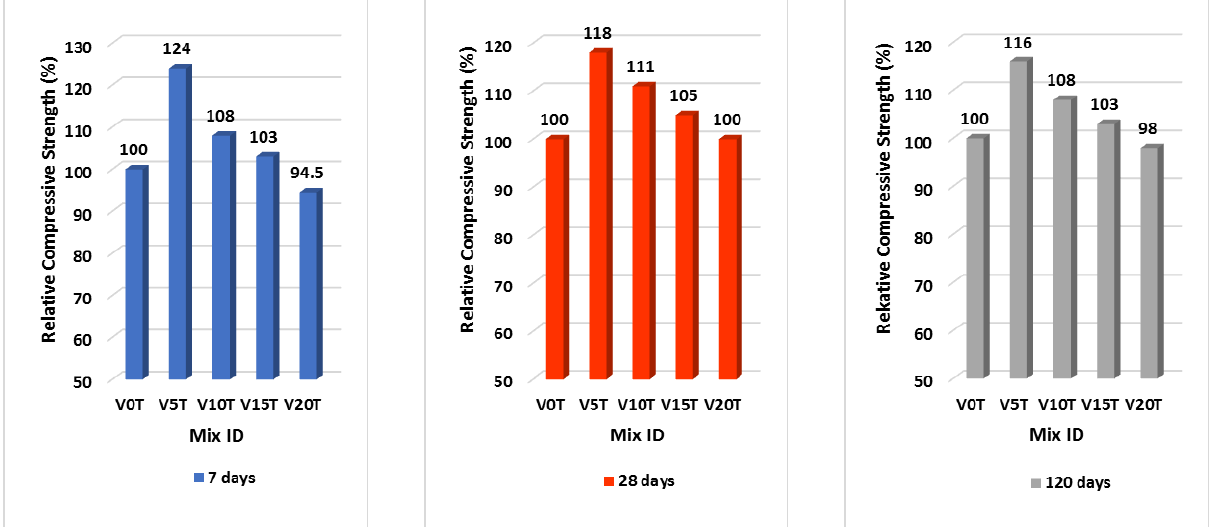
Figure 9. Effect of different ratios of VA on volcanic concrete compressive strength mixed with tap water.